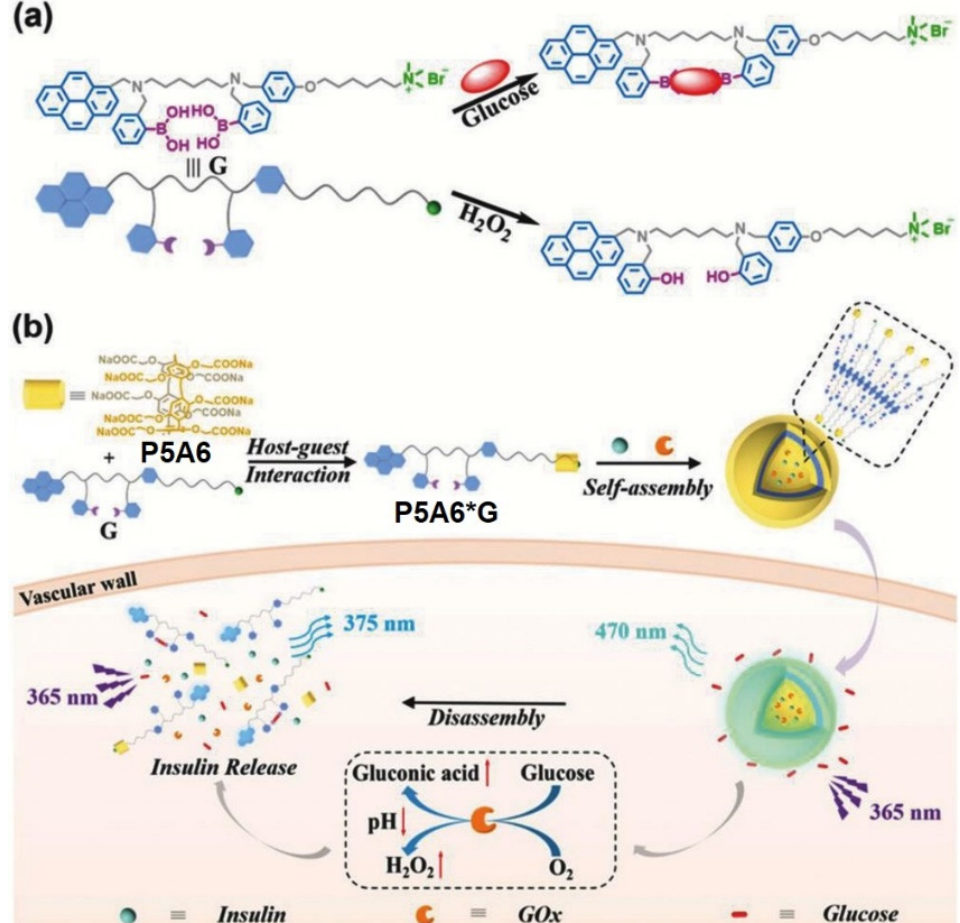
Figure 22. Schematic illustration of the glucose-responsive supramolecular insulin delivery system. ( a ) Chemical structure and the mechanism of the multiresponsive diphenylboronic acid guest G . ( b ) Supramolecular self-assembly of the host–guest complex “ P5A6*G ” into vesicles and their success- ful encapsulation of insulin and GOx as well as the efficient insulin release under hyperglycemic state. Reproduced from reference [108]. Copyright © Wiley 2018.